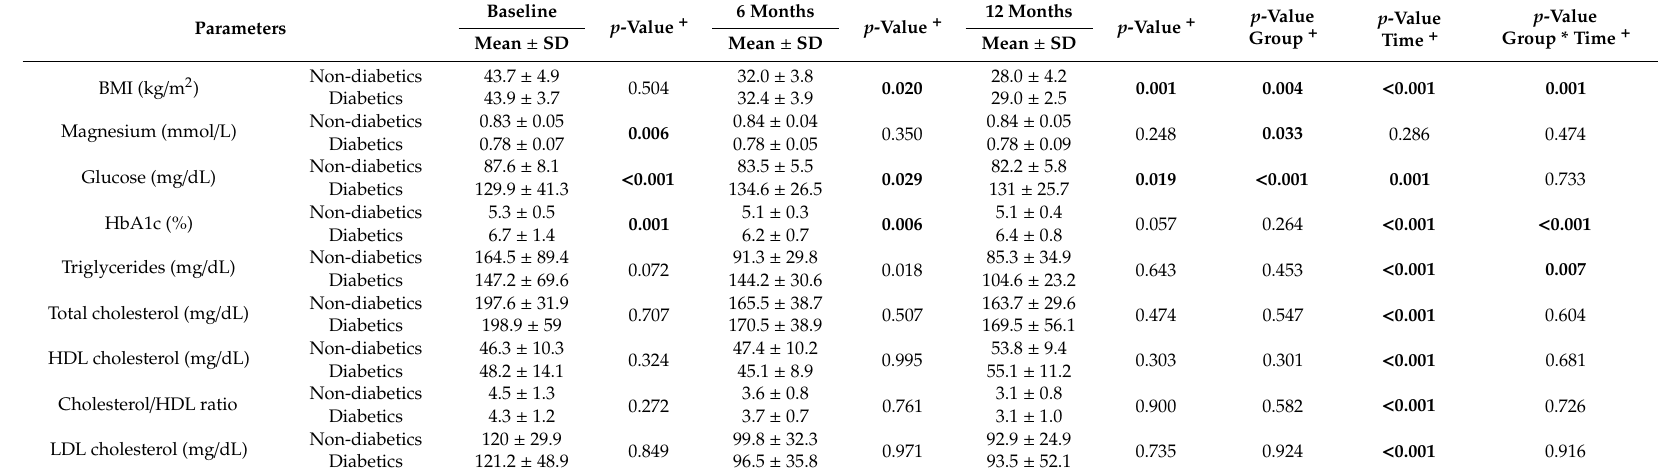
Table 2. Change in BMI, serum magnesium, glucose, and lipid parameters over time in diabetic and non-diabetic